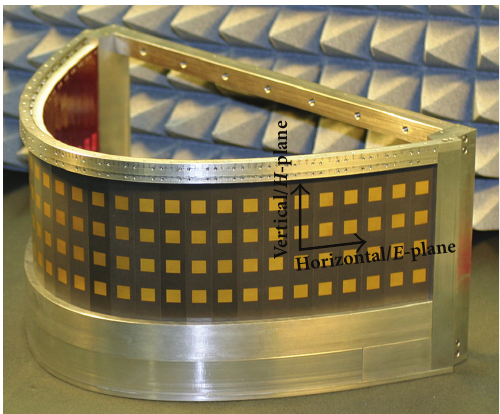
Figure 2: ERAKO antenna front-end showing the 30 sub-array columns. The polarization of the antenna elements is